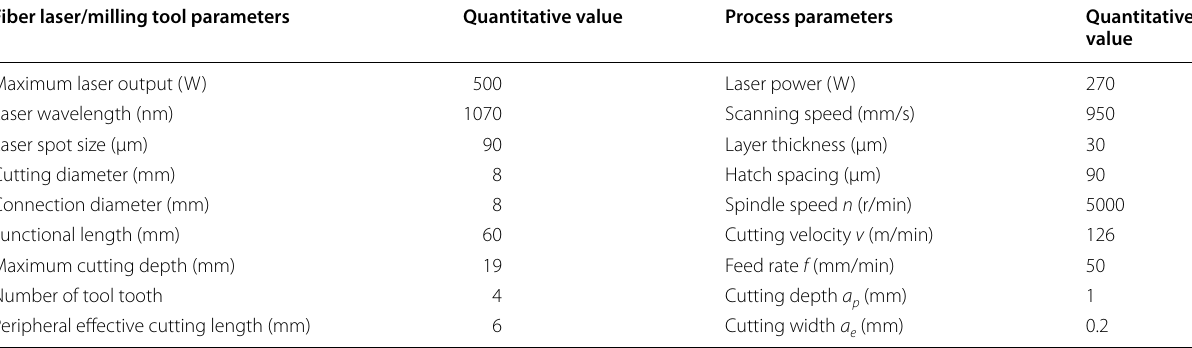
Table 3 Fiber laser/milling tool and process parameters Fiber laser/milling tool